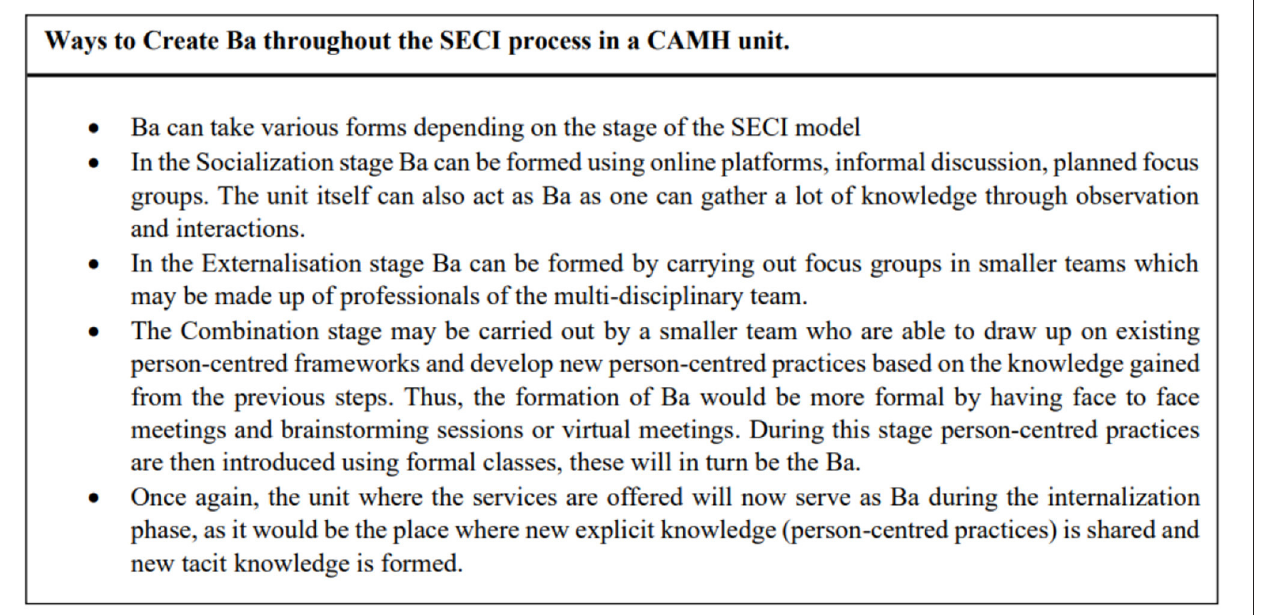
FIGURE 2 | Approaches to creating Ba in a CAMH